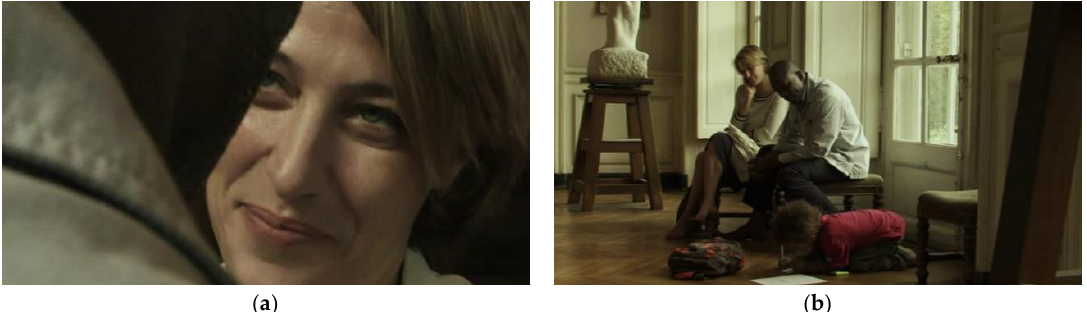
Figure 9. Frames from A Perfect Couple . A tight close-up of Valeria Bruni Tedeschi's face from a hand-held camera ( a ), followed by a wide shot that encompasses her whole conversation ( b ). Source: DVD edition by Intermedio (Spain).